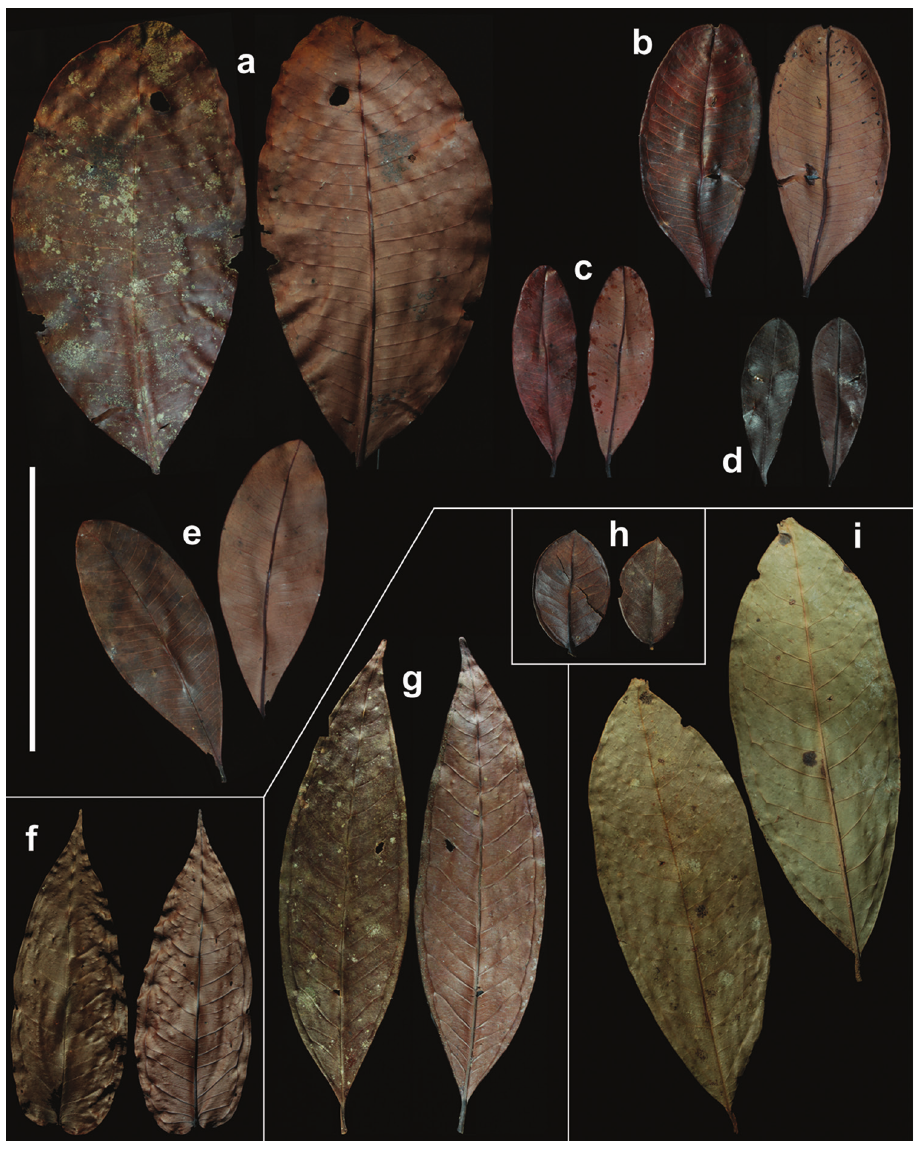
Figure 8. Leaves of all new species described. Variation of Syzygium balgooyi ( a–e ), S. contiguum ( f ), S. devogelii ( g ), S. eymae ( h ), and S. galanthum ( i ). a Brambach et al. 0283 b Brambach et al. 0681 c Bram- bach et al. 1333 d de Vogel 5413 [ L.2517563 ] e Culmsee r2162 f Culmsee r463 g Brambach et al. 0818 h Eyma 3624 [ L.2535689 ] i Brambach et al. 0533 . Scale bar: 10 cm, valid for all leaves. 4–10 mm long before anthesis, yellowish green, anthers c. 1 mm long, ovoid or el- lipsoid, yellow. Ovary bilocular, locules surrounded by spongy tissue, ovules many per locule, ascending. Style 10 mm long before anthesis, pointed,